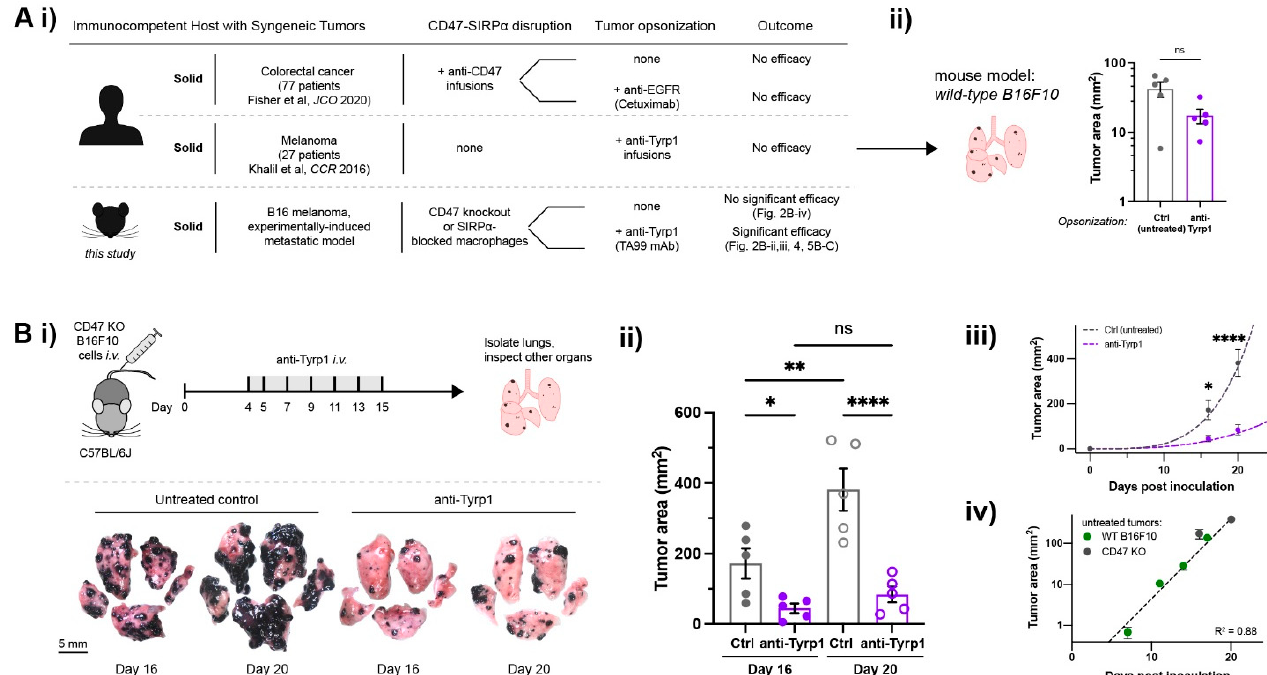
Figure 2. Tumor-opsonizing antibodies can drive regression of metastases only when CD47 is disrupted. ( A ) (i) Human clinical CD47 blockade in solid tumors compared to our main design of a suitable preclinical model (mouse). Anti-CD47 monotherapies show no efficacy, motivating a combination with tumor-opsonizing antibodies (e.g., Cetuximab in colorectal cancer). Anti-Tyrp1 monotherapy also showed no efficacy against human melanoma. Two distinct approaches are taken in our model. (ii) Anti-Tyrp1 opsonization of established wild-type (WT) B16F10 melanoma metastases does not significantly affect lung tumor burden on day 14 after tail-vein inoculation with 2 × 10 5 B16F10 cells. Tumors are allowed to establish, and mice are then tail-vein injected with anti-Tyrp1 (250 µg dosing) on days 4, 5, 7, 9, 11, and 13. Mice are sacrificed and organs are surveyed for B16F10 metastases. Results are illustrative of three independent experiments ( n = 5 per group, mean ± s.e.m., n.s. not significant for p > 0.05, unpaired t-test). ( B ) CD47-deleted lung metastases require anti-Tyrp1 for significant suppression. (i) Mice are tail-vein injected with 2 × 10 5 CD47 KO B16F10 cells on day 0 and later treated by tail-vein injections of anti-Tyrp1 (75 µg dosing). Mice are sacrificed and organs are surveyed for metastases, but only the lung shows nodules. Representative images from untreated controls or anti-Tyrp1 treatment. (ii) Tumor area on both sides of lung lobes were quantified, showing significant suppression by anti-Tyrp1 ( n = 5 per group, mean ± s.e.m.; * p < 0.05, ** p < 0.01, **** p < 0.0001, one-way ANOVA, uncorrected Fisher’s LSD). (iii) Exponential-type growth (as power law: Area = A 0 t B : A 0 , ctrl = 0.0019, A 0 , tx = 0.0087, B ctrl = 4.1, B tx = 3.0). (iv) CD47 deletion does not affect tumor growth relative to WT (Area = A 0 e k*t , where A 0 = 0.05, k = 0.45). Here, we focus first on poorly immunogenic, syngeneic B16F10 melanoma cells in lung [18] to model solid tumor metastasis within immunocompetent C57BL/6 mice. Dele- tion of CD47 on opsonized B16F10s increases the engulfment of cell suspensions in vitro by bone marrow-derived macrophages in our recent studies [19]. We now find that in vivo efficacy against established B16F10 metastatic nodules requires both CD47 deletion and a pro-phagocytic, melanocyte-specific IgG. Our quantitative analyses of tumor growth with CD47 deletion together with high-resolution imaging indicates on-target phagocytosis with IgG opsonization in B16F10 tumor suppression. In a second approach, we modify marrow macrophages for an adoptive cell therapy by pre-blocking SIRP α and pre-loading Fc-receptors with tumor-opsonizing IgG prior to infusion. Human lung carcinoma A549 liver metastases in immunodeficient mice confirm the effects of this cell therapy and thus confirm the benefits of the combination